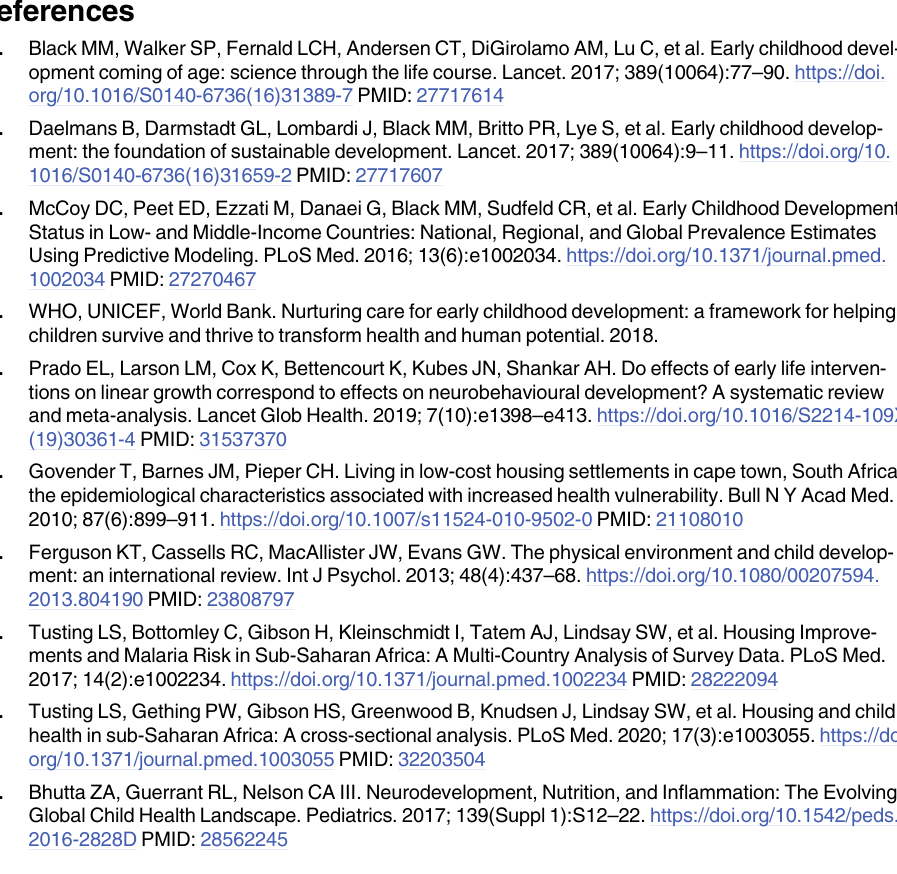
S2 Fig. Mutually adjusted association between housing quality and ECD in children aged 36–59 months in SSA. ECD, early childhood development; SSA, sub-Saharan Africa. S1 Checklist. STROBE checklist. STROBE, Strengthening the Reporting of Observational Studies in